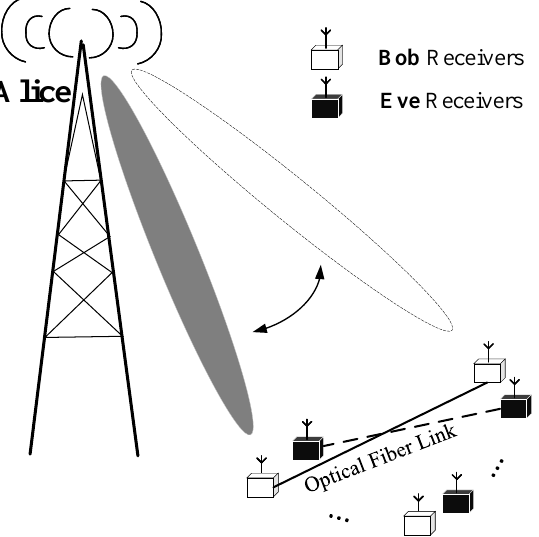
Figure 1. Systematic scenario of directional